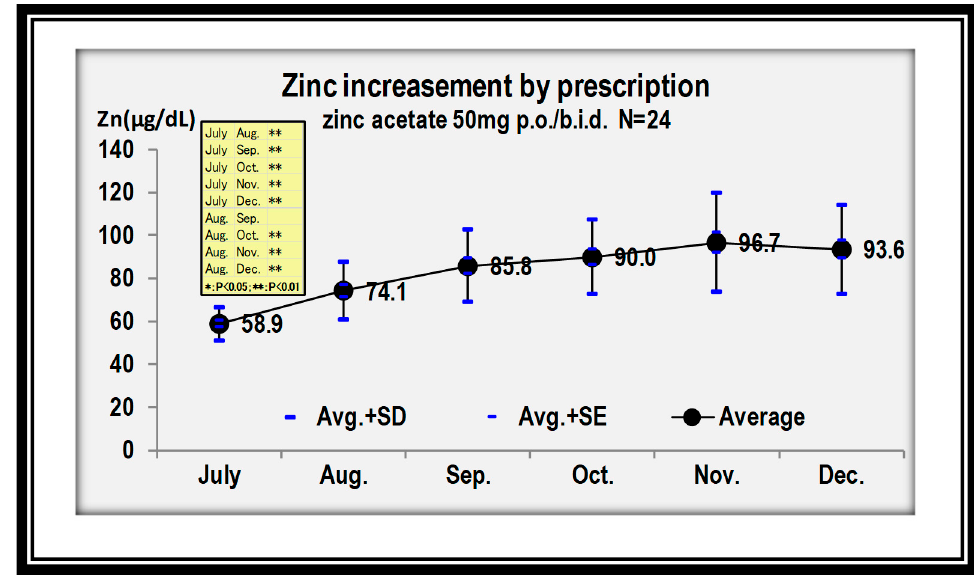
Figure 7. Increment of zinc by prescribing zinc acetate 50 mg/b.i.d, P.O. * P < 0.05. ** P <